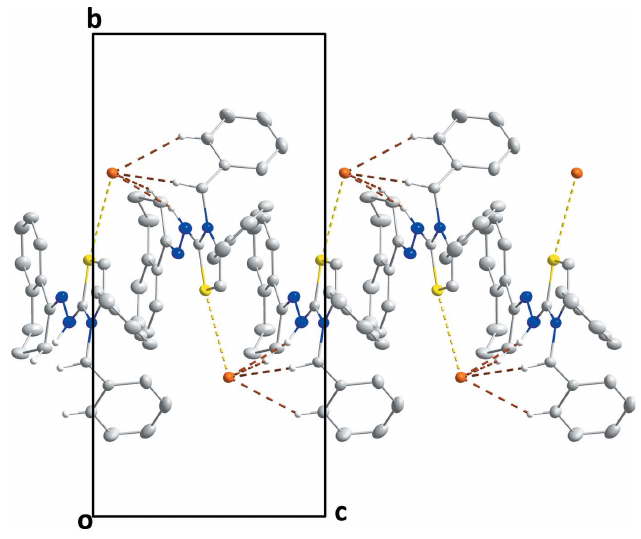
Figure 2 Detail of a supramolecular chain viewed along the a -axis direction with